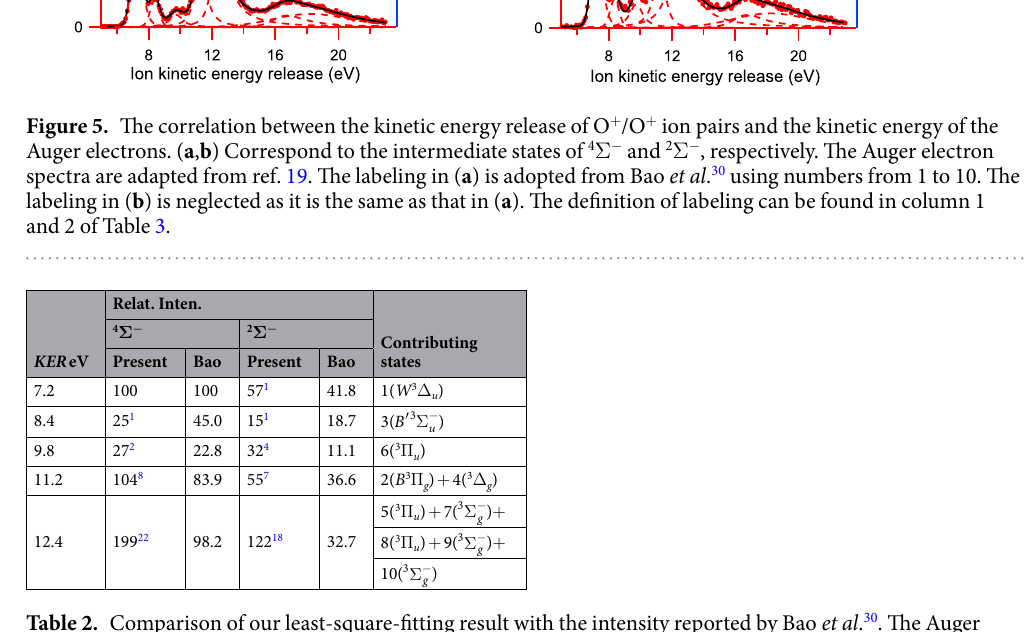
Table 2. Comparison of our least-square-fitting result with the intensity reported by Bao et al . 30 . The Auger transition rates in each column are normalized to the first decay 4 Σ − → W 3 Δ u . The errors are shown in square